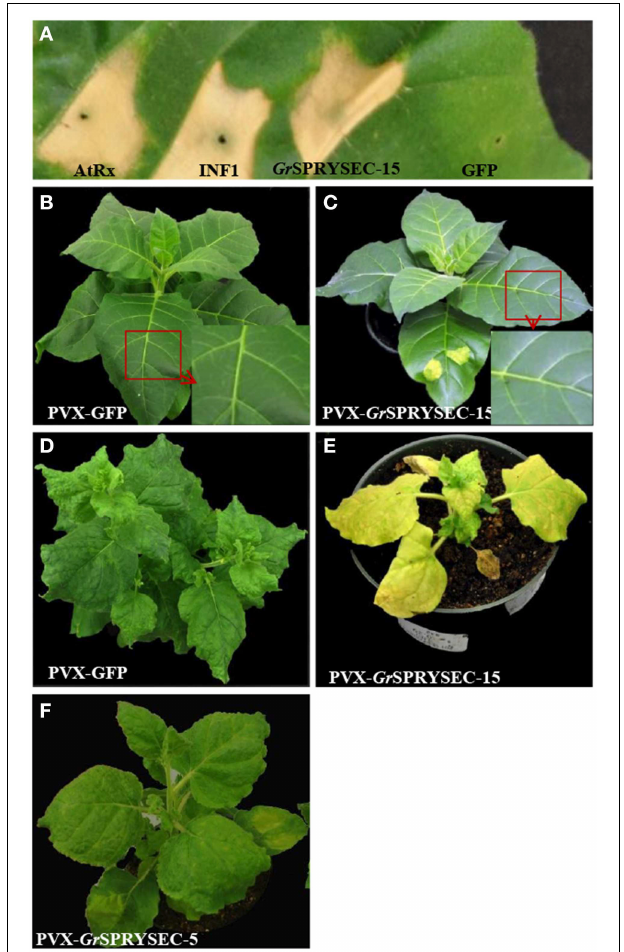
FIGURE 1 | Gr SPRYSEC-15 induces a hypersensitive response in N. tabacum and chlorosis in N. benthamiana . (A) N. tabacum leaves were infiltrated with Agrobacterium carrying pEAQ35S expressing AtRx, INF1, Gr SPRYSEC-15, or GFP as indicated. Leaves were photographed at 4 DPI. (B) N. tabacum inoculated by agroinfiltration with PVX-GFP vector or (C) PVX- Gr SPRYSEC-15. Pictures were taken at 14 DPI. Insets show close ups